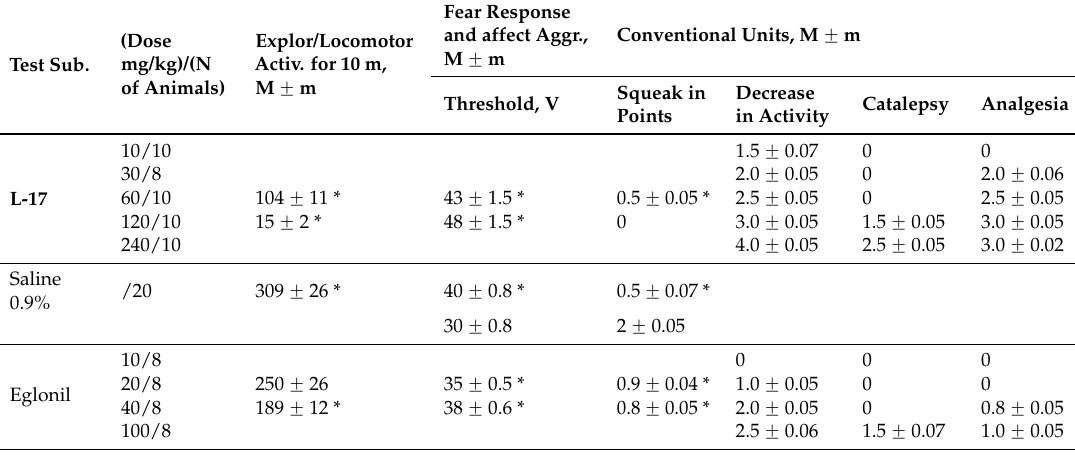
Table 1. Effects of 2-morpholino-5-phenyl-6 H -1,3,4-thiadiazine (compound L-17 ) and Eglonyl on overall exploratory/locomotor activity, fear response, and affective aggression.